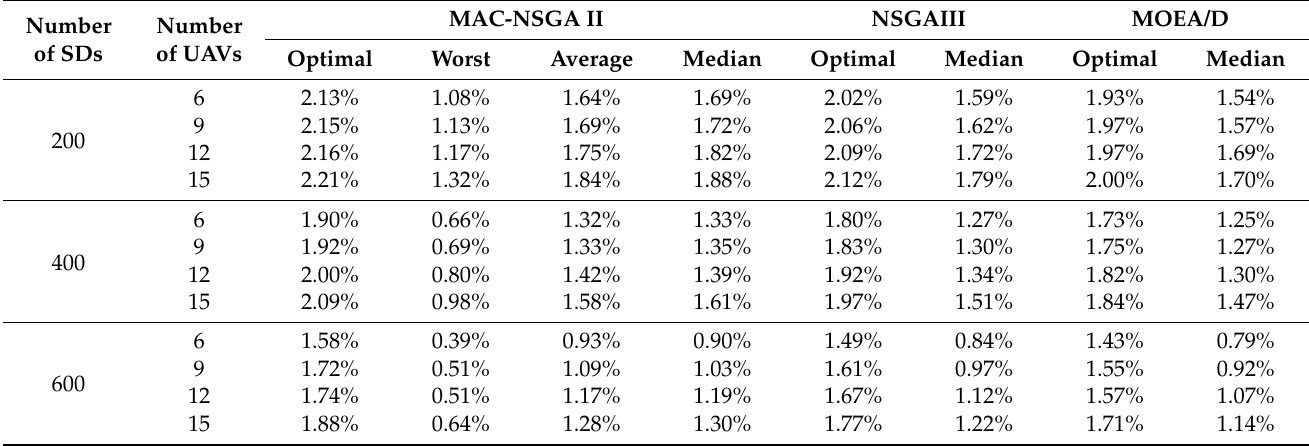
Table 5. The energy efficiency of UAV with longest